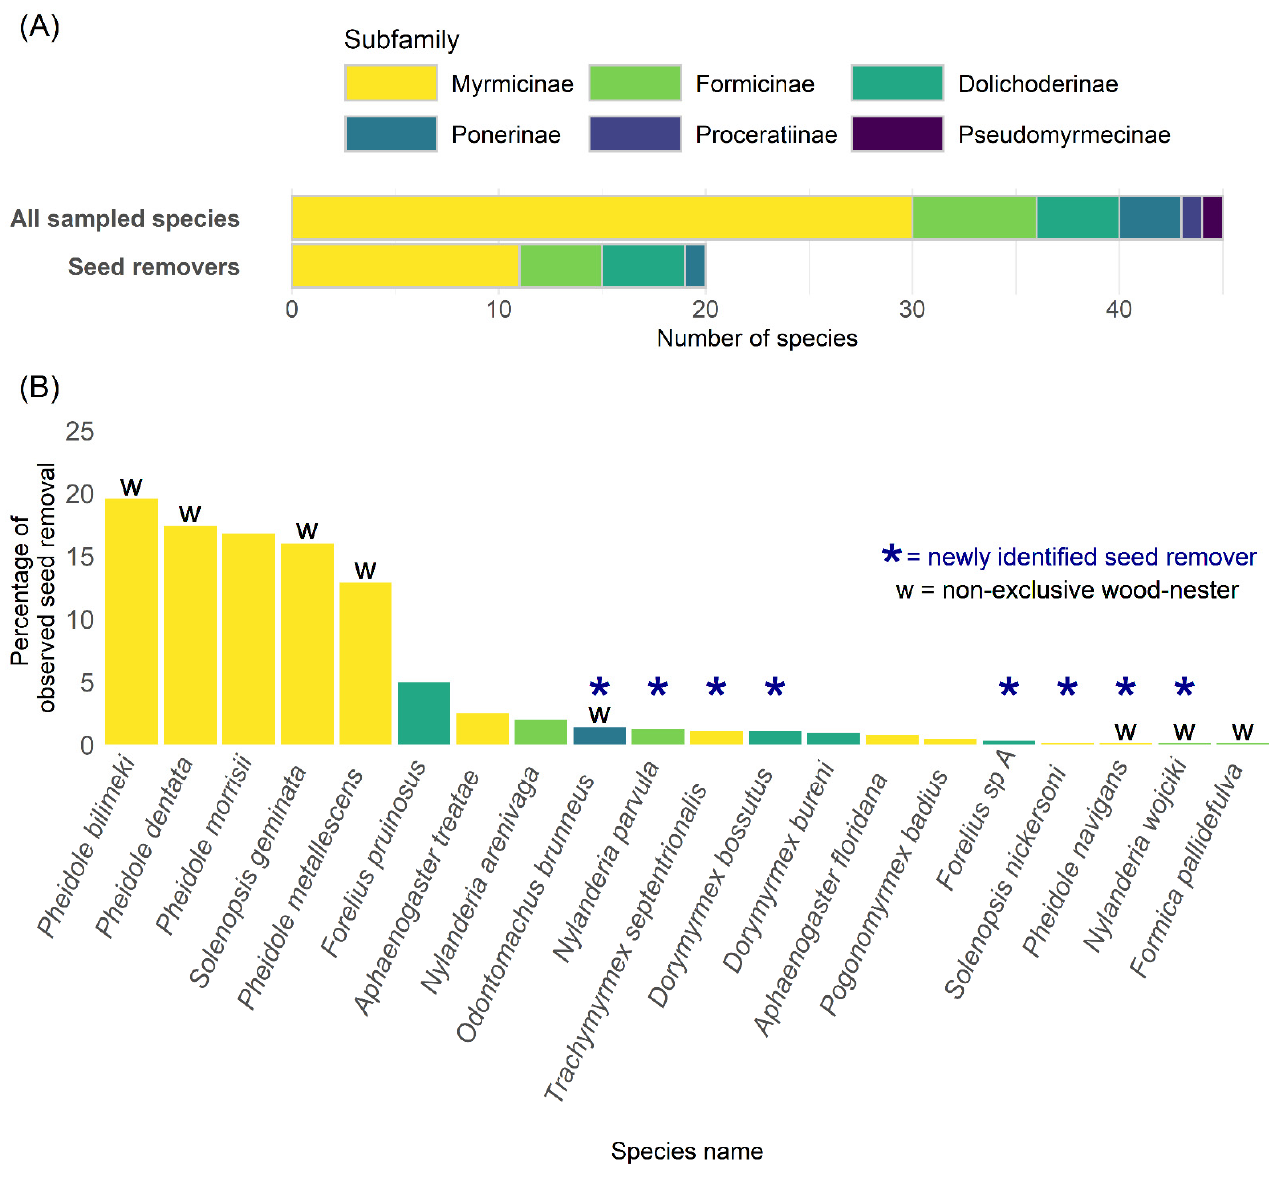
Figure 3. ( A ) Subfamily breakdown of all species sampled compared to the subset of species identified as seed removers. ( B ) Seed-removing ant species and the percent of seeds each species removed out of 644 total seeds removed across the entire study. Asterisks denote new observations of seed removal for a species. “w” identifies the species as a non-exclusive wood nester.